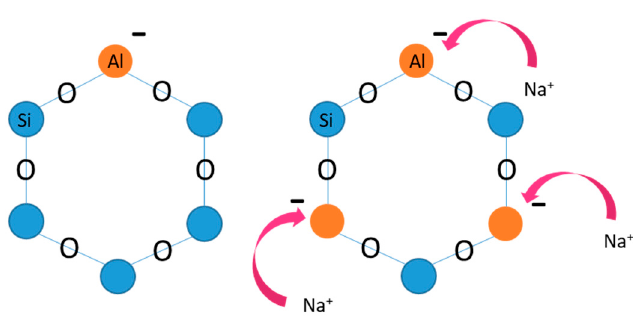
Figure 1. Al 3+ and Si 4+ cation sites. The Al-O 4 are responsible for the excess of negative valent in Al positions and the substitution with a cation (Na, K and other).